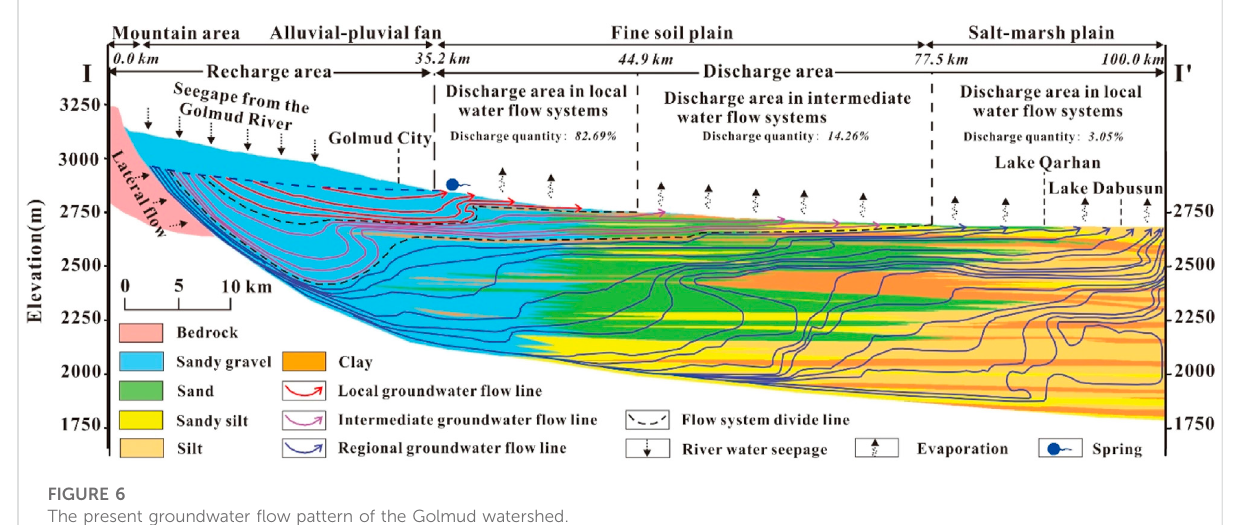
FIGURE 6 The present groundwater fl ow pattern of the Golmud